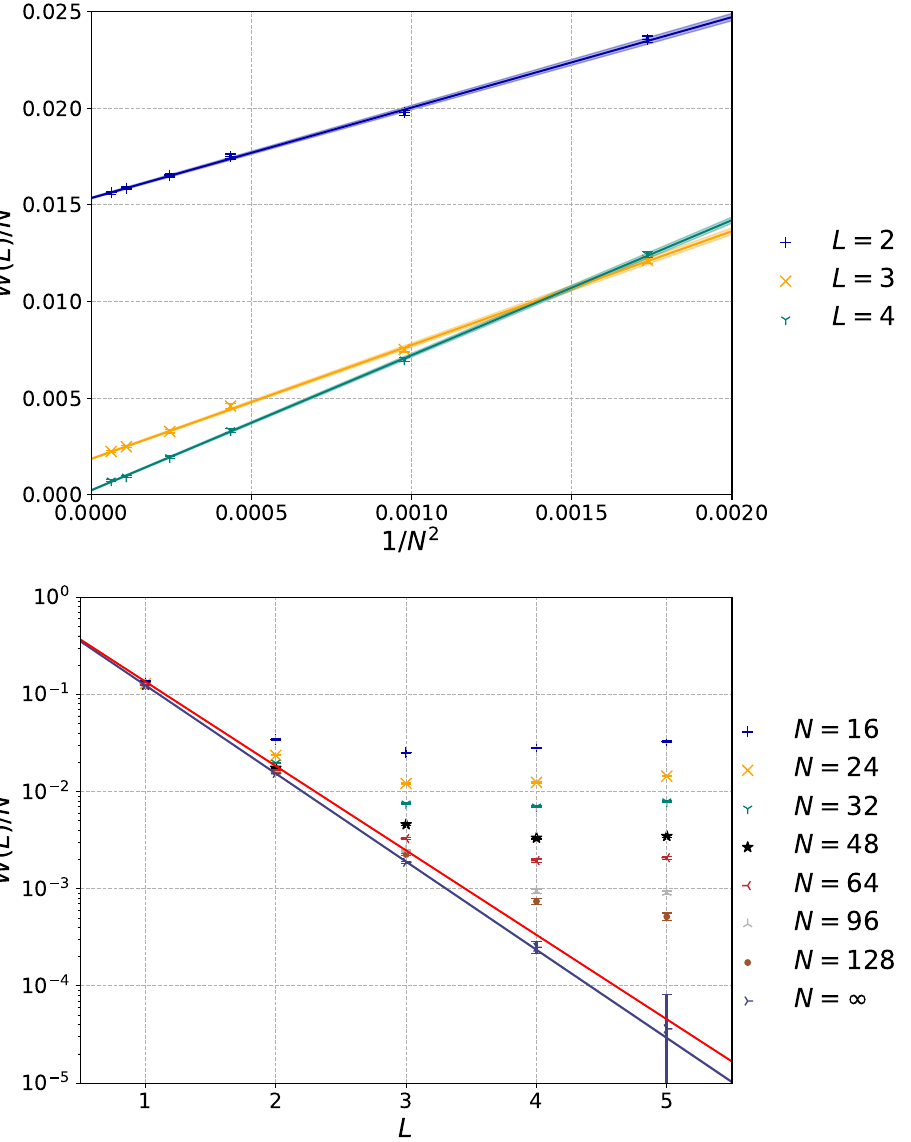
Figure 6. T = 0 . 25 and n t = 24 , without constraint. Temperature is sufficiently low such that the completely-confined phase is realized automatically. For the extrapolation to N = ∞ , we used data points at N = 24 , 32 , 48 , 64 , 96 , 128 for L = 1 , 2 , 3 , 4 and N = 48 , 64 , 96 , 128 for L = 5 . We used the fitting ansatz 1 W ( L ) = a ( L ) + b ( L ) . By fitting the large- N extrapolated results at 1 ≤ L ≤ 4 N N 2